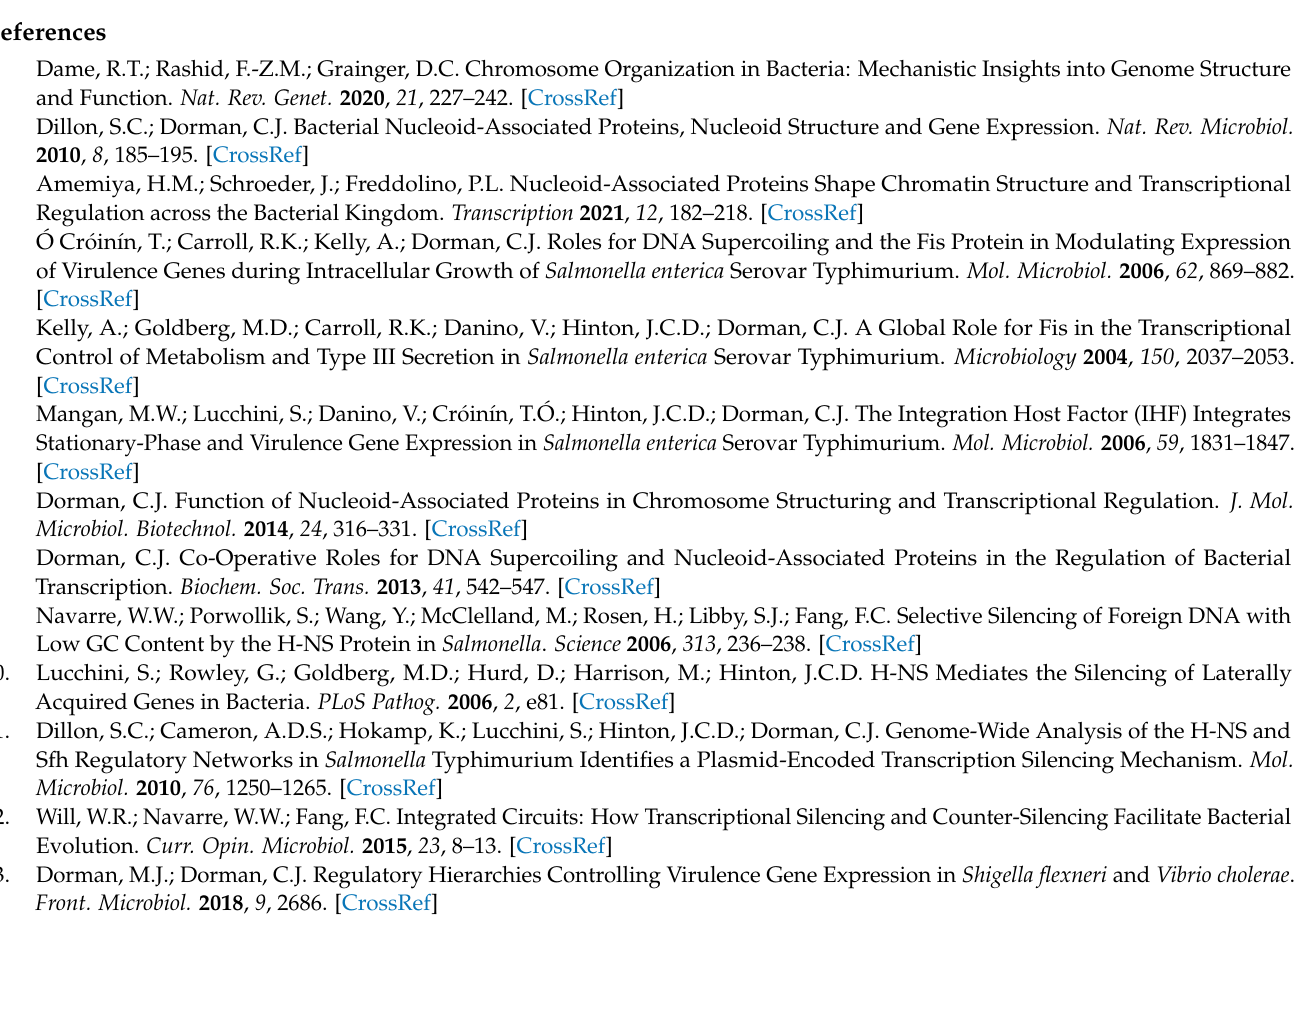
Figure S2 : Results obtained from MetaLogo [2]. ( a ) Sequence counts of each group; ( b ) Entropy heatmap of each group; ( c ) Boxplot of entropies of positions in all groups; ( d ) Clustering result of sequence logo groups revealing the pairwise relationships; ( e ) Distribution of pairwise distances of the nodes in the phylogenetic tree; Table S1: Homologous group, accession to InterPro database, strain ID, sequence length, and sequence match for